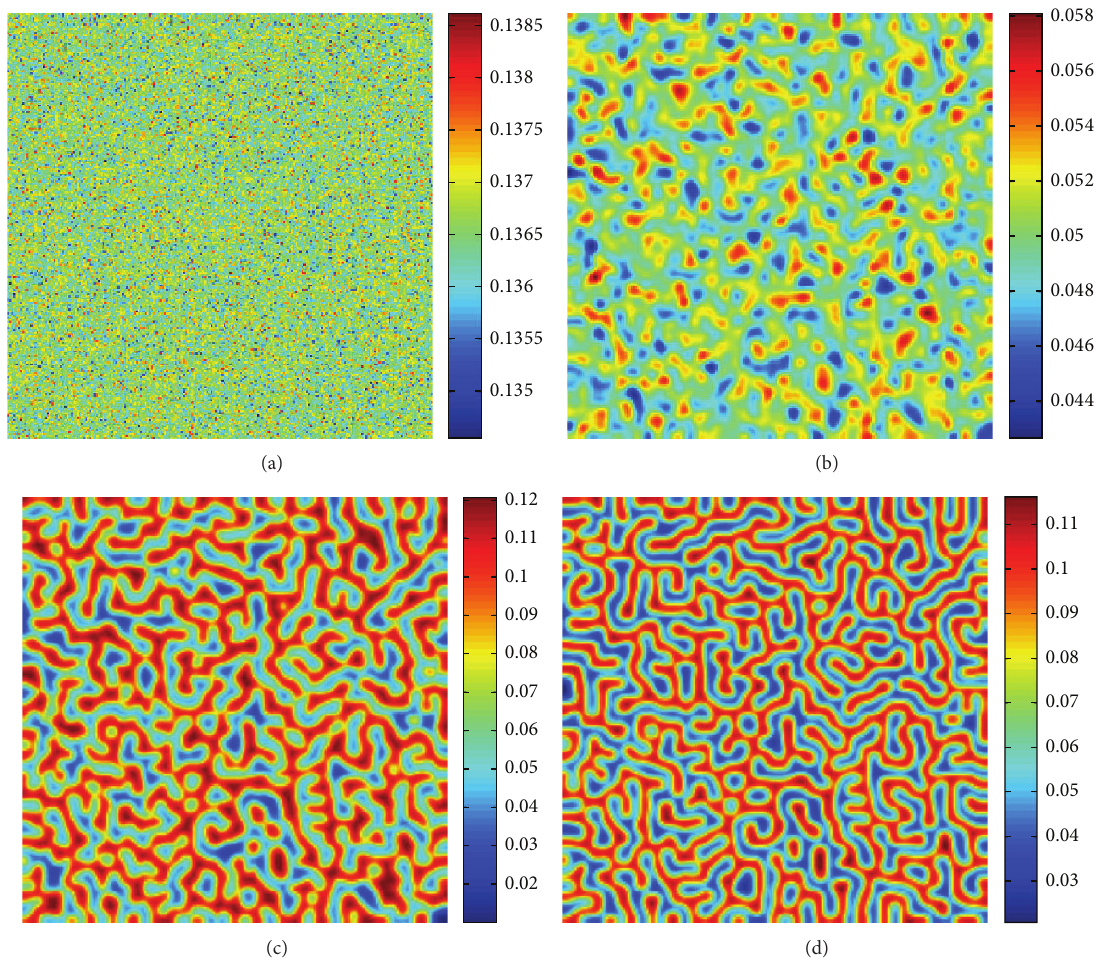
Figure 4: Snapshots of the time evolution of the prey at different instants with 𝛼 = 0 . 6, 𝛽 = 0 . 8, 𝛾 = − 0 . 3, 𝛿 = 0 . 58, 𝜃 = 2 . 2, 𝑑 1 = 0 . 08, 𝑑 2 = 1, and 𝜏 = 0 . 2, which are in the Turing space. (a) 0 iterations; (b) 5000 iterations; (c) 10000 iterations; (d) 100000